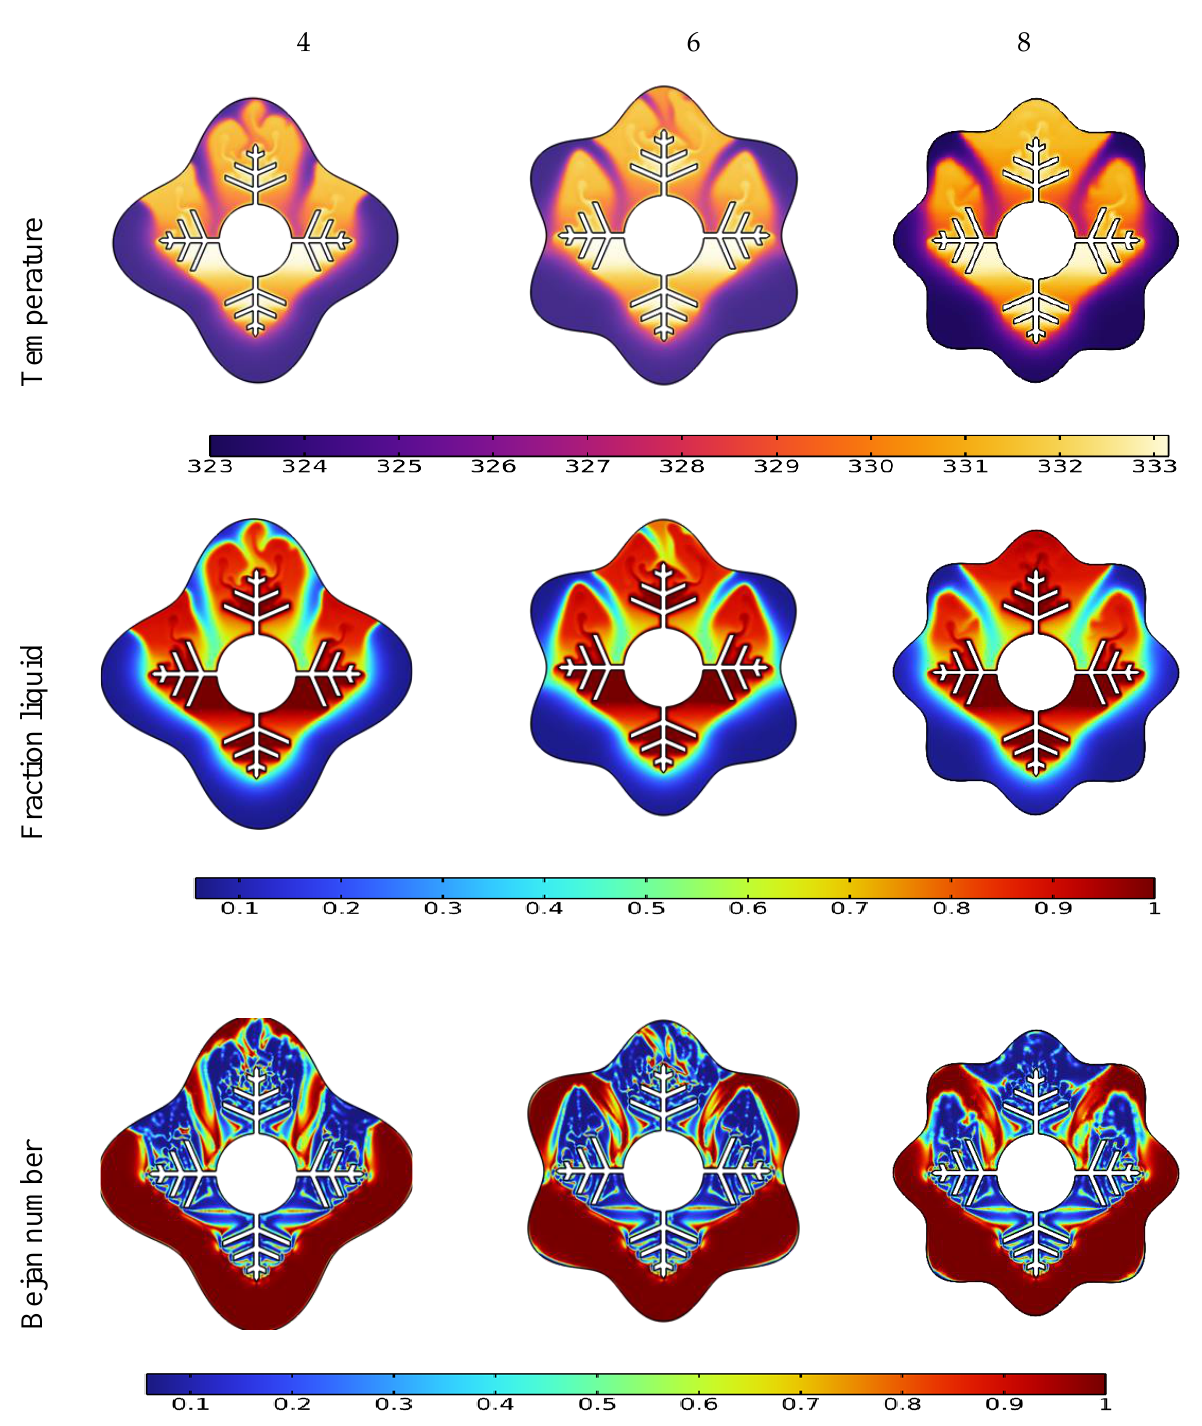
Figure 7. Effect of wave number N on temperature, liquid fraction, and Bejan number during the PCM melting process after 10 min.